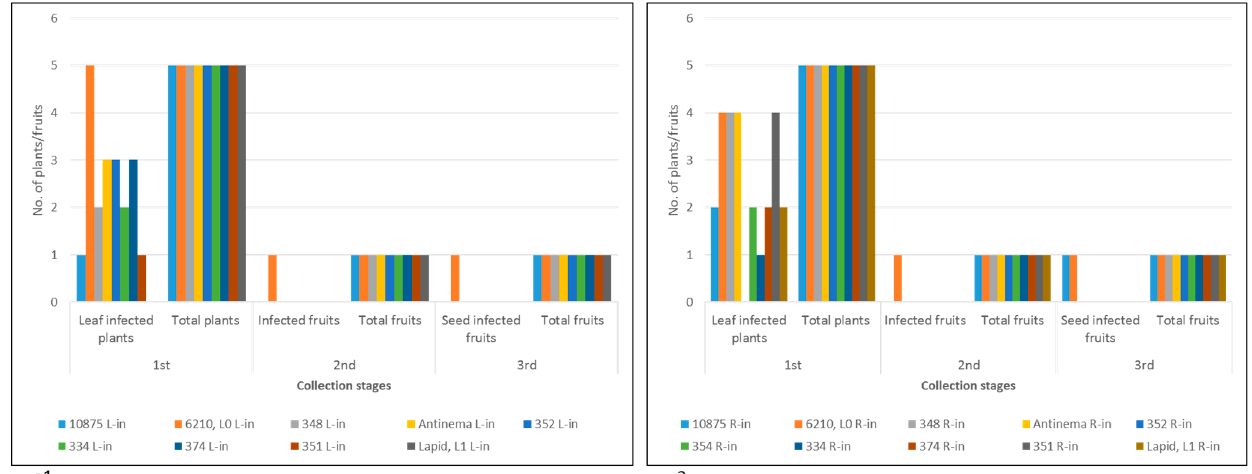
Figure 2. ELISA results of ToBRFV in leaves, fruits, and seeds of UD varieties, L 1 Lapid, and L 0 cv. 6210 plants at several collection stages: ( a1 ) ToBRFV in leaf-inoculated UD varieties, L 1 Lapid, and L 0 cv. 6210 plants; ( a2 ) ToBRFV in root-inoculated UD varieties, L 1 Lapid, and L 0 cv. 6210 and plants; L, leaf-inoculated; R, root-inoculated.